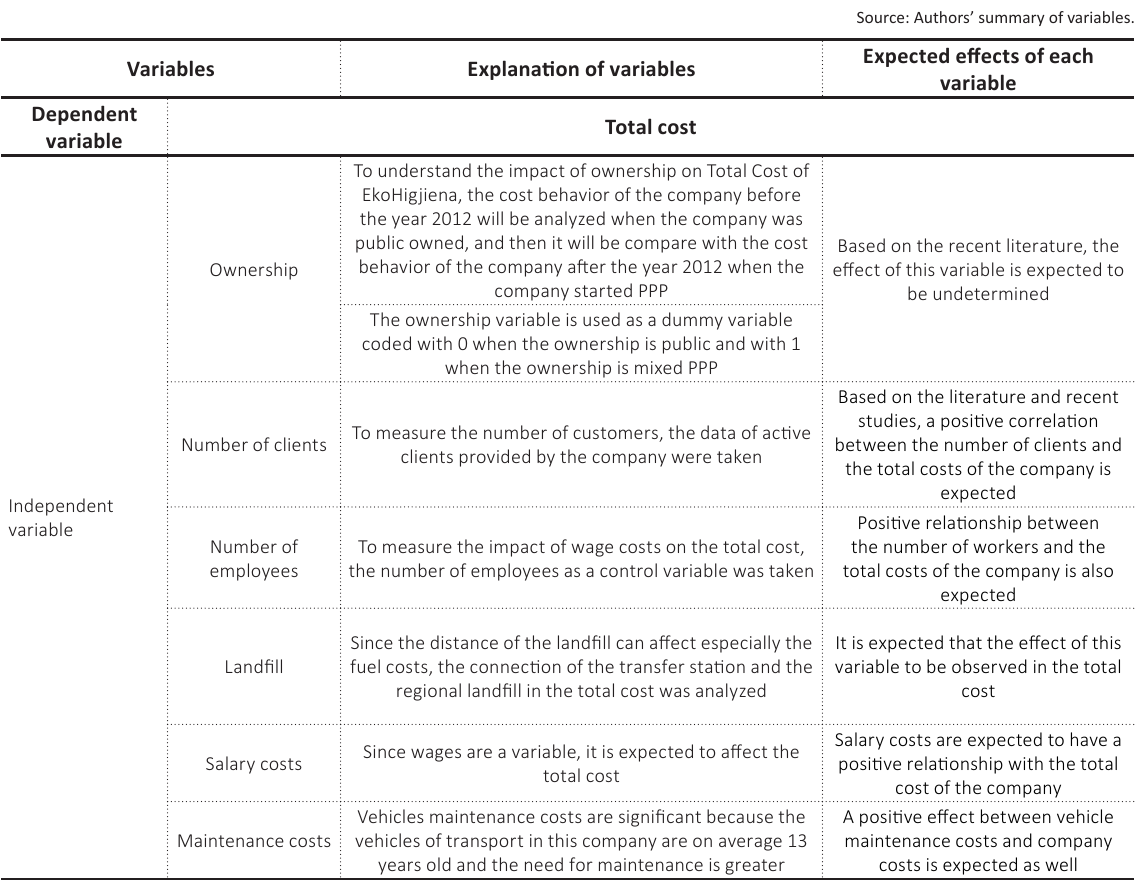
Table 2. Explanation of variables